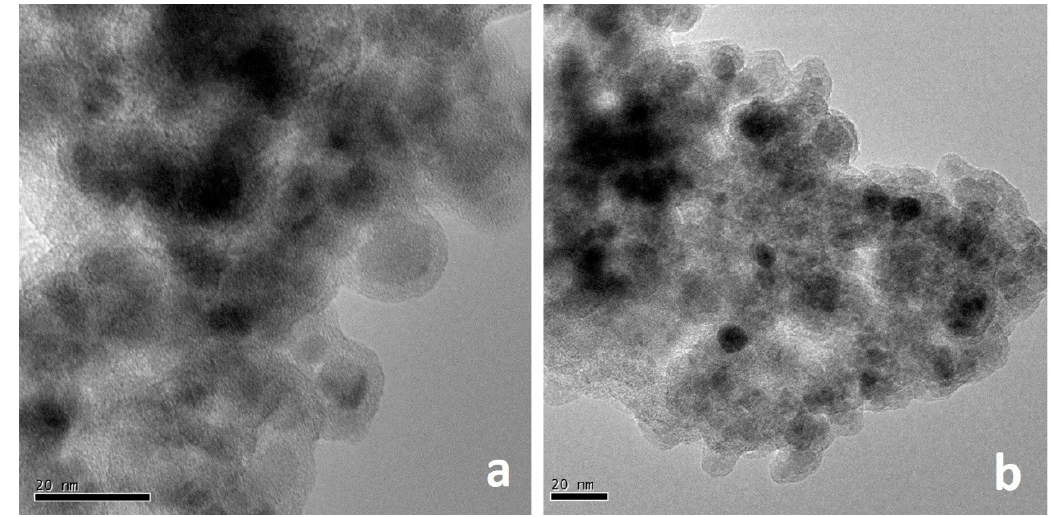
Figure 2. TEM images of composite, ( a ) shows SiO 2 @Fe 3 O 4 -RGO and ( b ) shows Au-SiO 2 @Fe 3 O 4